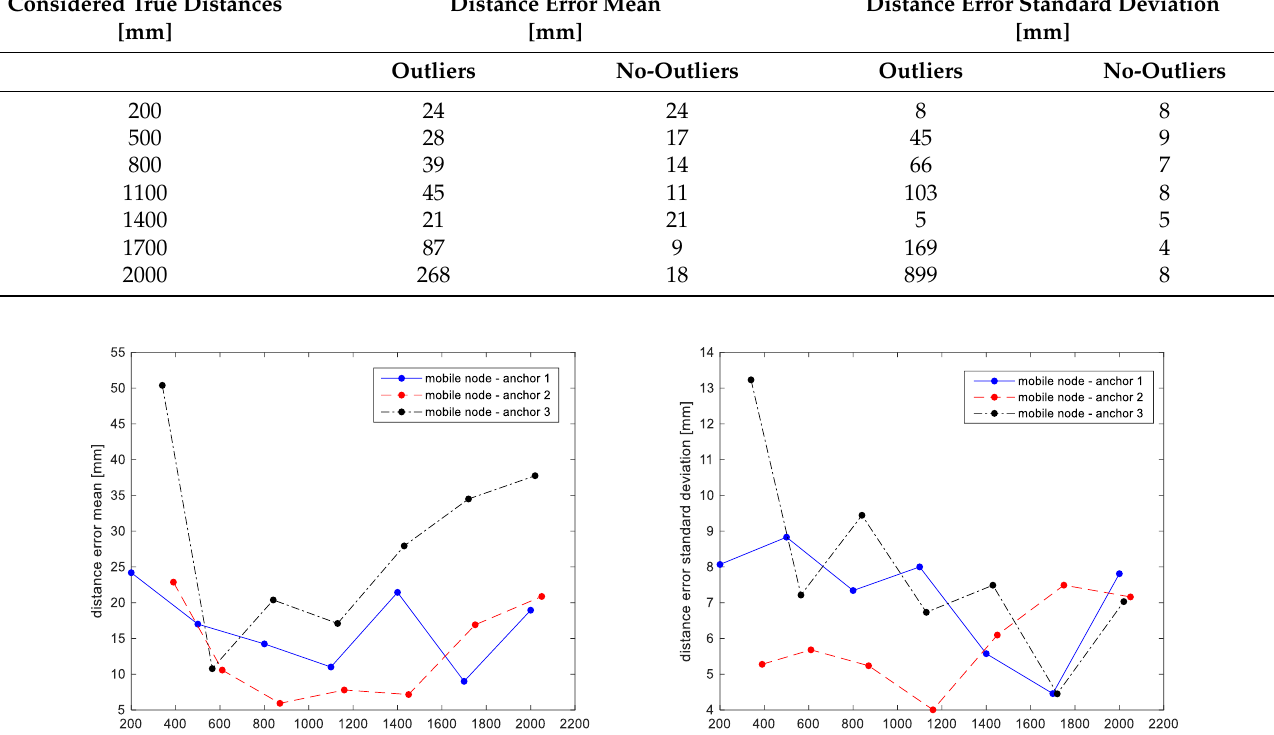
Figure 6. Mean ( left ) and standard deviation ( right ) of the estimated distance error for the couple of nodes (mobile node – anchor 1).